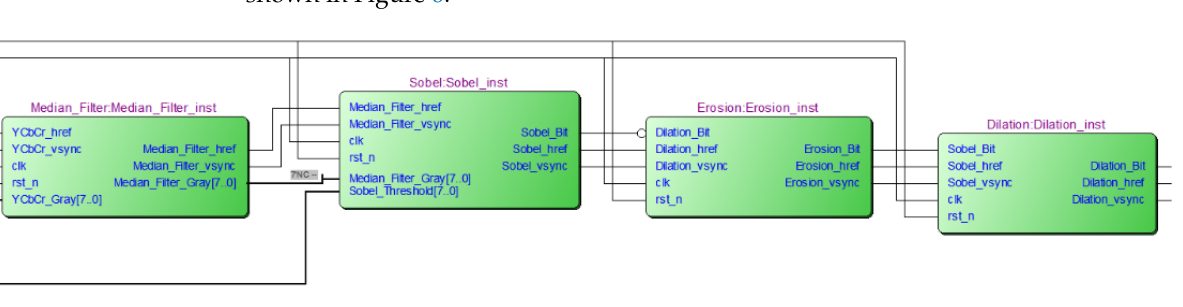
3 × 3 window extraction window. 3 × 3